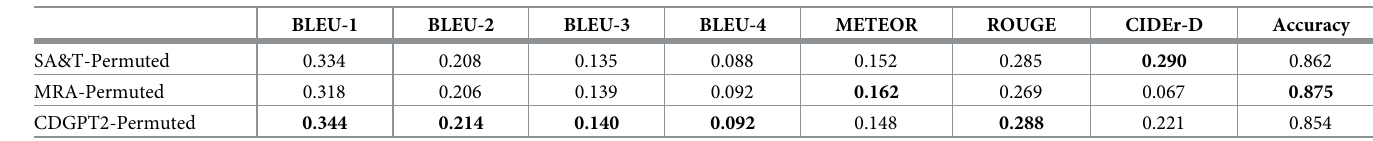
Table 3. Results on the IU chest X-ray dataset of permuted models.